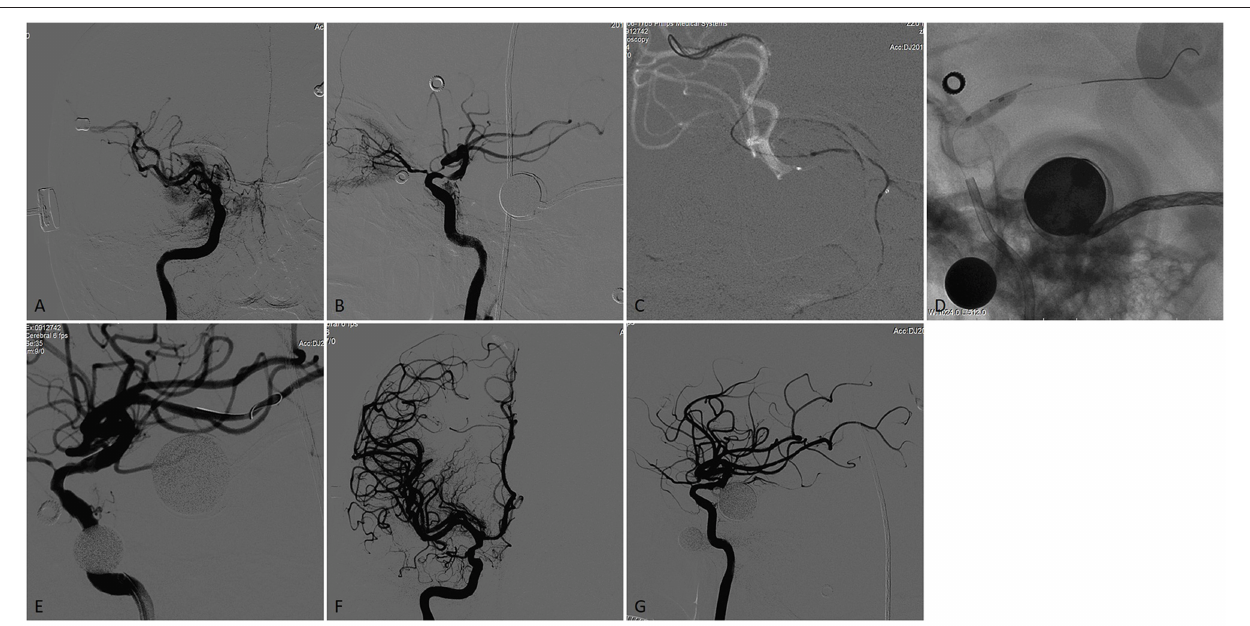
FIGURE 2 | A patient who had a previous history stroke and presented again with recurrent TIAs recently. (A,B) Right internal carotid arteriogram on anteroposterior and lateral view demonstrated a focal severe (90%) stenosis of the right supraclinoid ICA with flow reduction in the distal territory. (C) A 0.014 inch microwire was anchored in the distal branch of the MCA with the microwire tip manipulated a U- shaped loop inside the vessel. (D) The stenotic lesion was dilated with a 3.5 × 9-mm Gateway balloon. (E) The lesion showed significant improvement of the stenosis immediately after angioplasty. (F) and G. A 4.5 × 15-mm Neuroform EZ stent was deployed across the lesion, Final angiography showed near 20% residual stenosis with flow augmentation in the distal